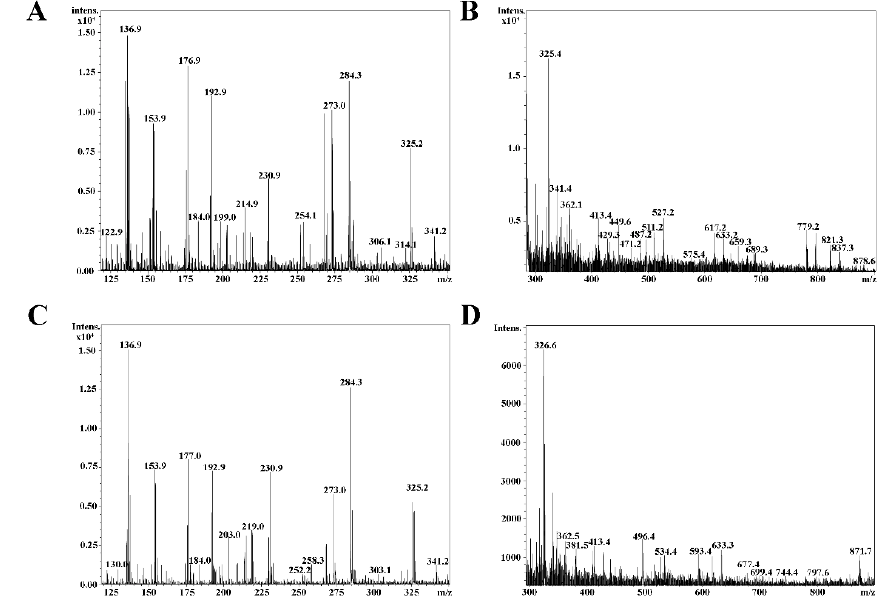
Figure 4. Mass Spectrometry results. MALDI-TOF mass spectra of compounds from Allium ursinum leaf liophylisate (WGLL) extracts, using 2,5-Dihydroxybenzoic acid (DHB) matrix. ( A – B ) Compounds previously separated by C18 column; ( A ) Compounds with relatively low molecular weight; B: compounds with higher molecular weight; ( C – D ) components of WGLL extract, previously separated by silica S100 column; ( C ) Compounds with relatively low molecular weight; ( D ) Compounds with higher molecular weight.